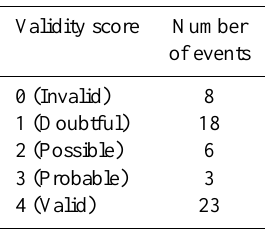
Table 5. Number of reported tsunamis for each assigned validity score from 0 (invalid) to 4